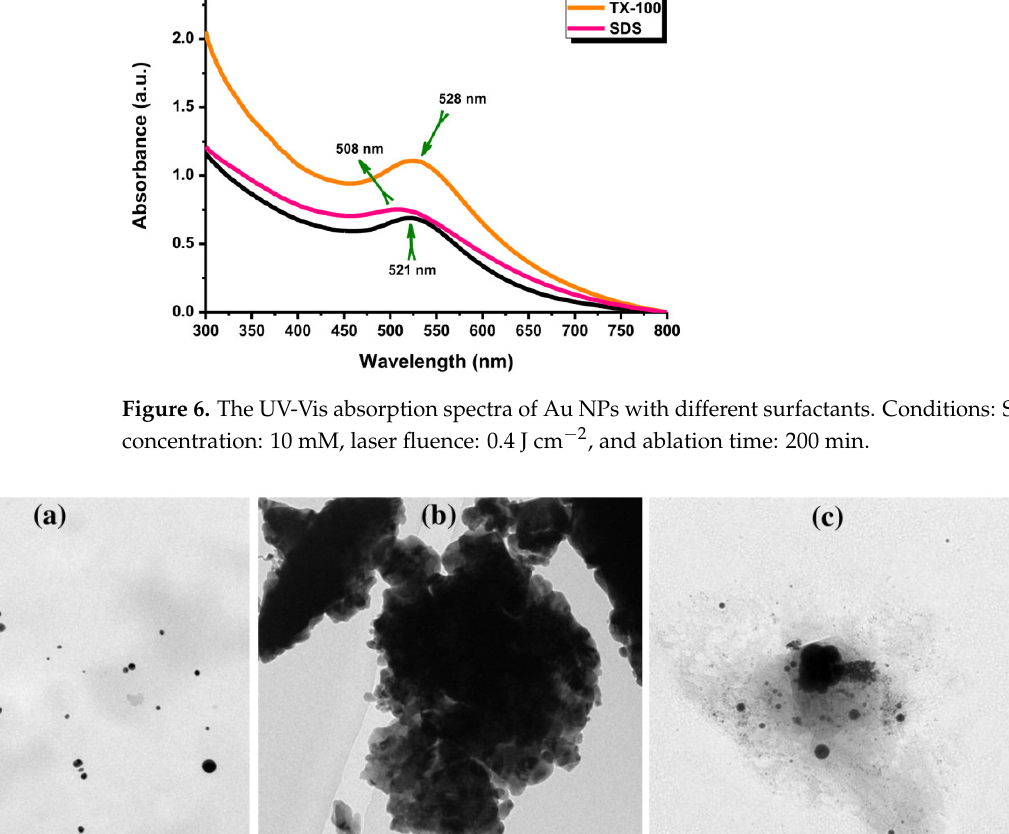
Figure 7. The TEM images of Au NPs using ( a ) CTAB, ( b ) TX-100, and ( c ) SDS with ablation time of 200 min and the laser fluence of 0.4 J cm −2 . The surfactant concentration was 10 mM.